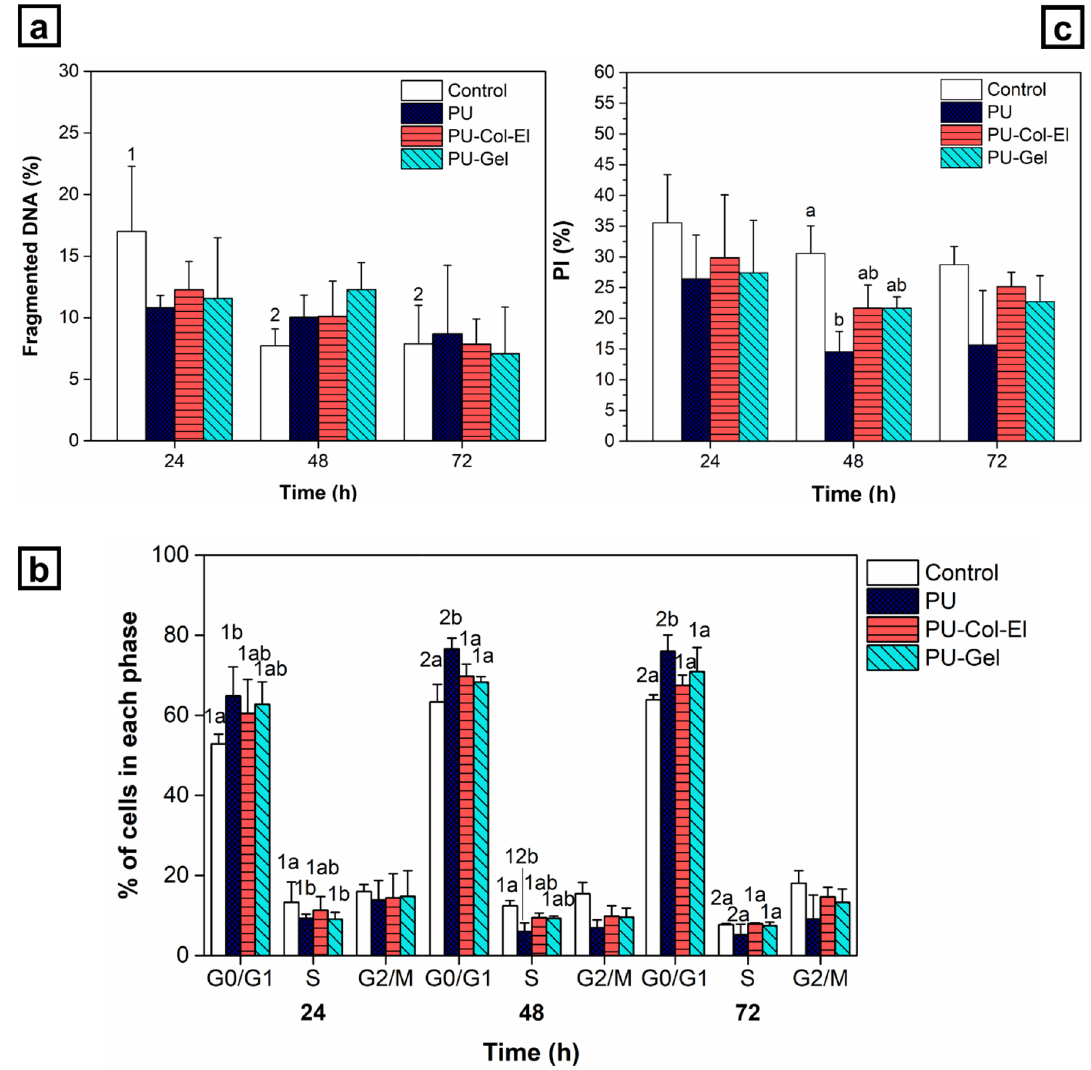
Figure 8. ( a ) Fragmented DNA, ( b ) cell cycle profile, and ( c ) proliferation index (PI) determined using flow cytometry in HUVECs treated with scaffolds. Statistical differences were analyzed using two-way ANOVA with a Bonferroni post-hoc test (a, b, c denotes a significant difference of p < 0.05 between scaffolds, while 1, 2, 3 indicates a significant difference of p < 0.05 between time